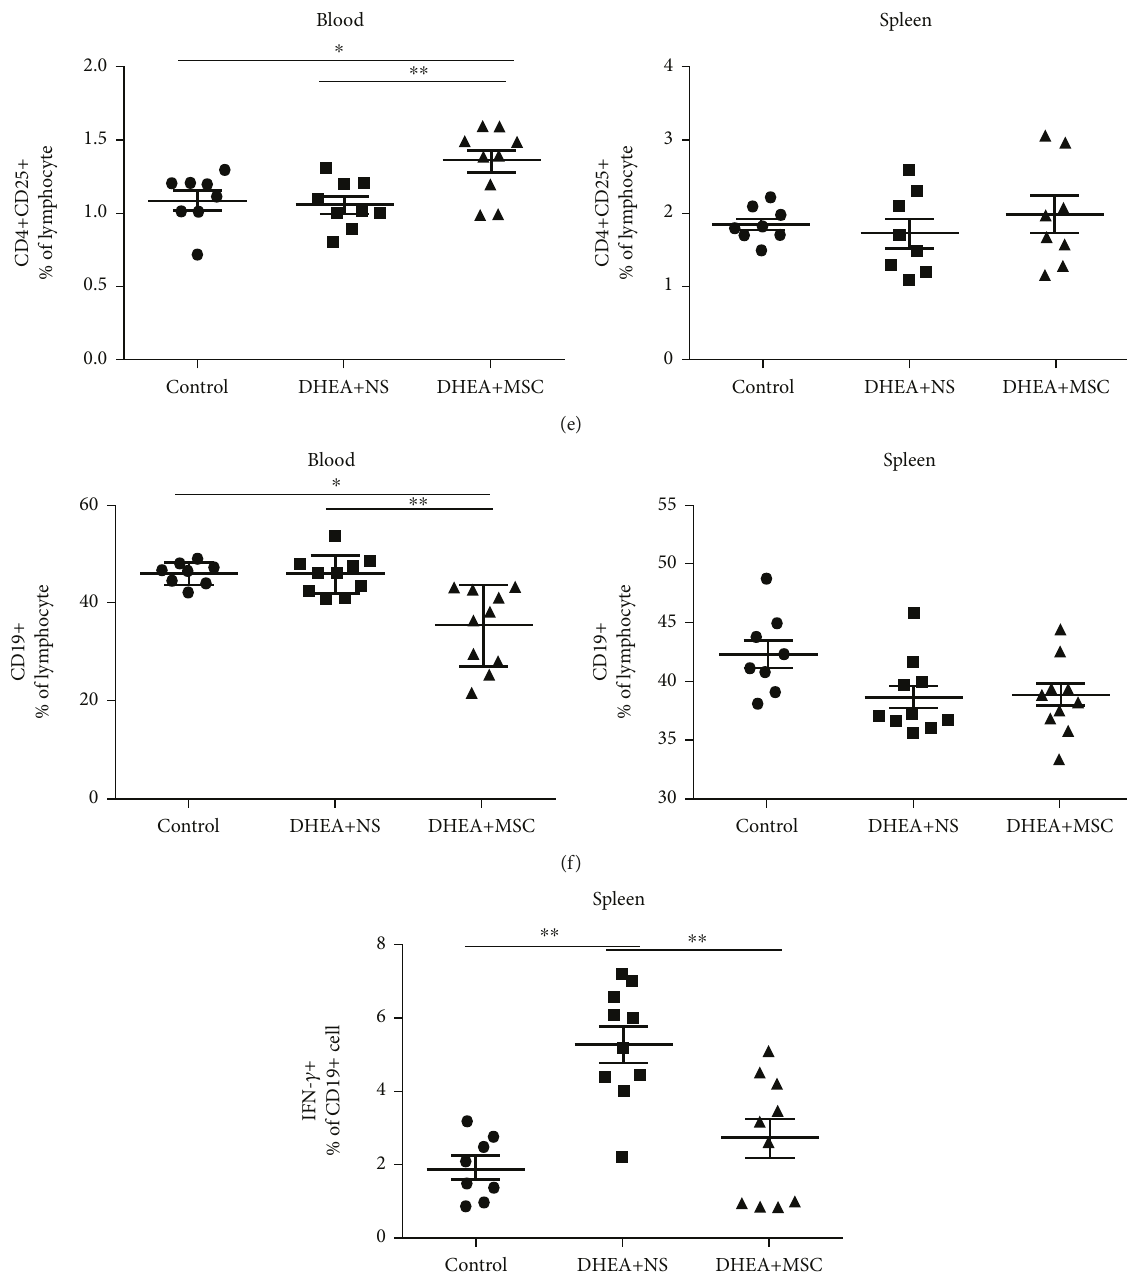
Figure 5: hUC-MSC treatment a ff ects T and B cell compartments in PCOS mice. Flow cytometry results of T and B cells in the peripheral blood and spleen. (a) The percentage of peripheral and splenic T cells (CD3 + ), T helper cells (CD3 + CD4 + ), and cytotoxic T cells (CD3 + CD8 + ). (b) The percentage of splenic IFN- γ + T helper cells (Th1). (c) The percentage of splenic IL-17 + T helper cells (Th17). (d) The percentage of splenic IL-4 + T helper cells (Th2). (e) The percentage of peripheral and splenic Tregs (CD4 + CD25 + ). (f) The percentage of peripheral and splenic B cells (CD19 + ). (g) The percentage of splenic IFN- γ + CD19 + B cells. n = 8 -10 per group. Values are expressed as the means ± SEM . ∗ P < 0 05 and ∗∗ P < 0 01